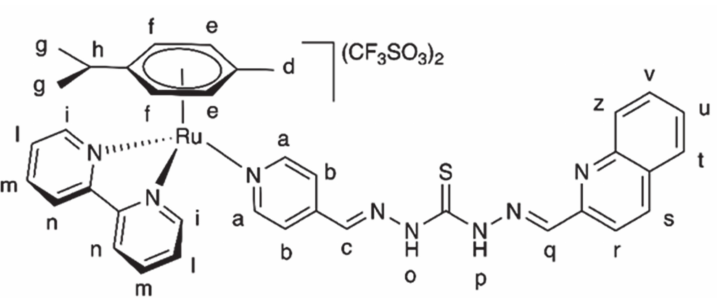
Figure 12. [( η 6 -p-cym)Ru(N,N (cid:48) -bpy)(N-4-formylpyridine-2-quinolinecarboxaldehydethiocarbohy -drazone)](SO 3 CF 3 ) 2